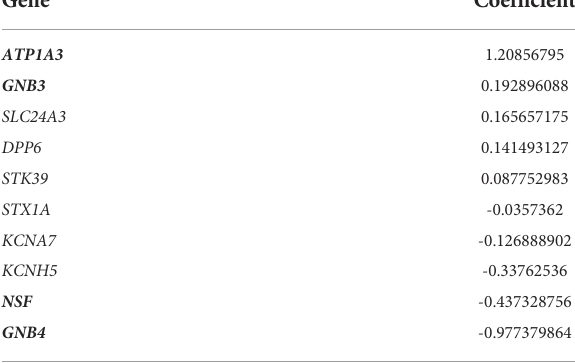
TABLE 2 Genes and their coef fi cients that constitute the PCRG